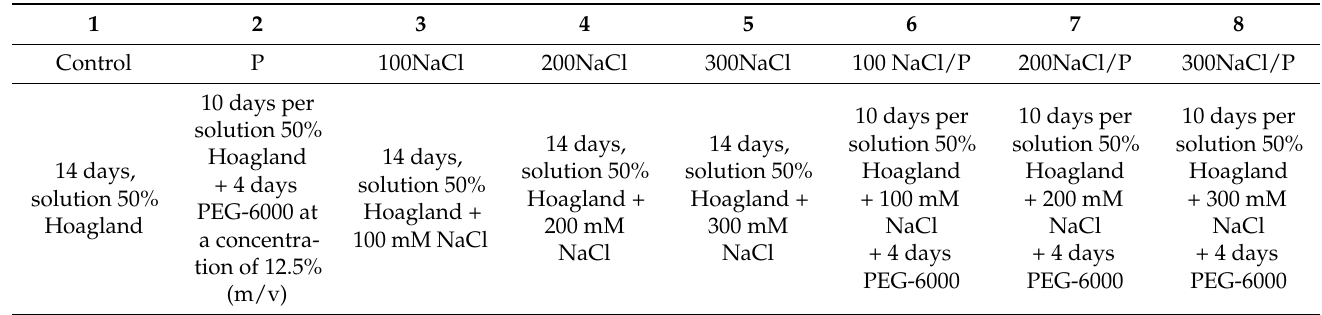
Table 1. Experimental growth conditions of Chenopodium quinoa